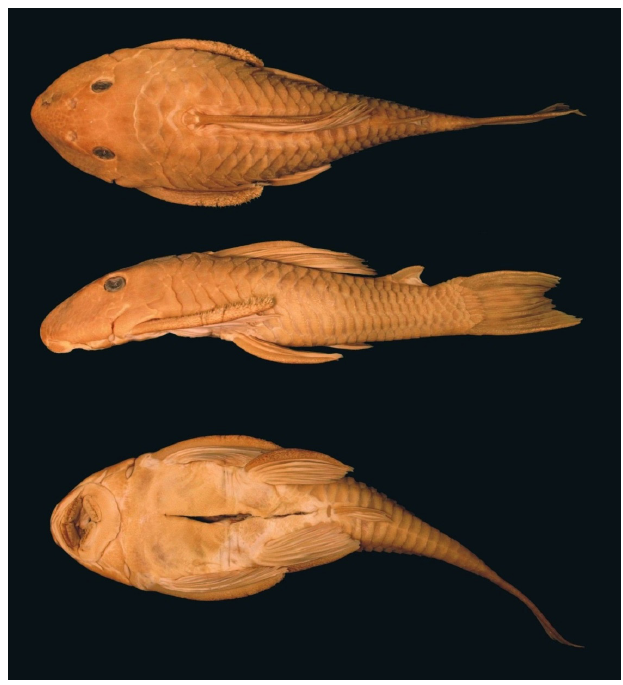
FIGURE 2 | Hypostomus hermanni , BMNH 1905.6.9.5, holotype, 201.8 mm SL; Brazil, São Paulo State, Piracicaba, Piracicaba River, Upper Paraná River basin. Dorsal, lateral and ventral